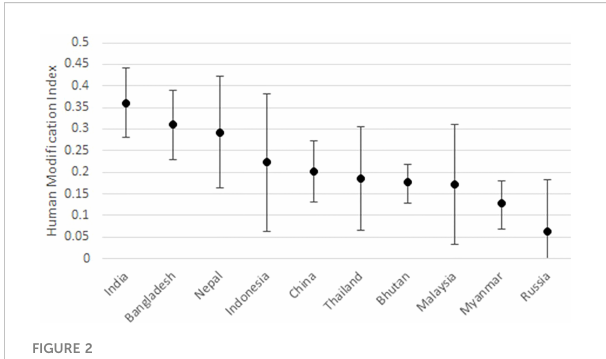
FIGURE 2 Mean (± Standard Deviation) Human Modi fi cation Index (HMI) scores for current tiger distribution in each extant tiger range